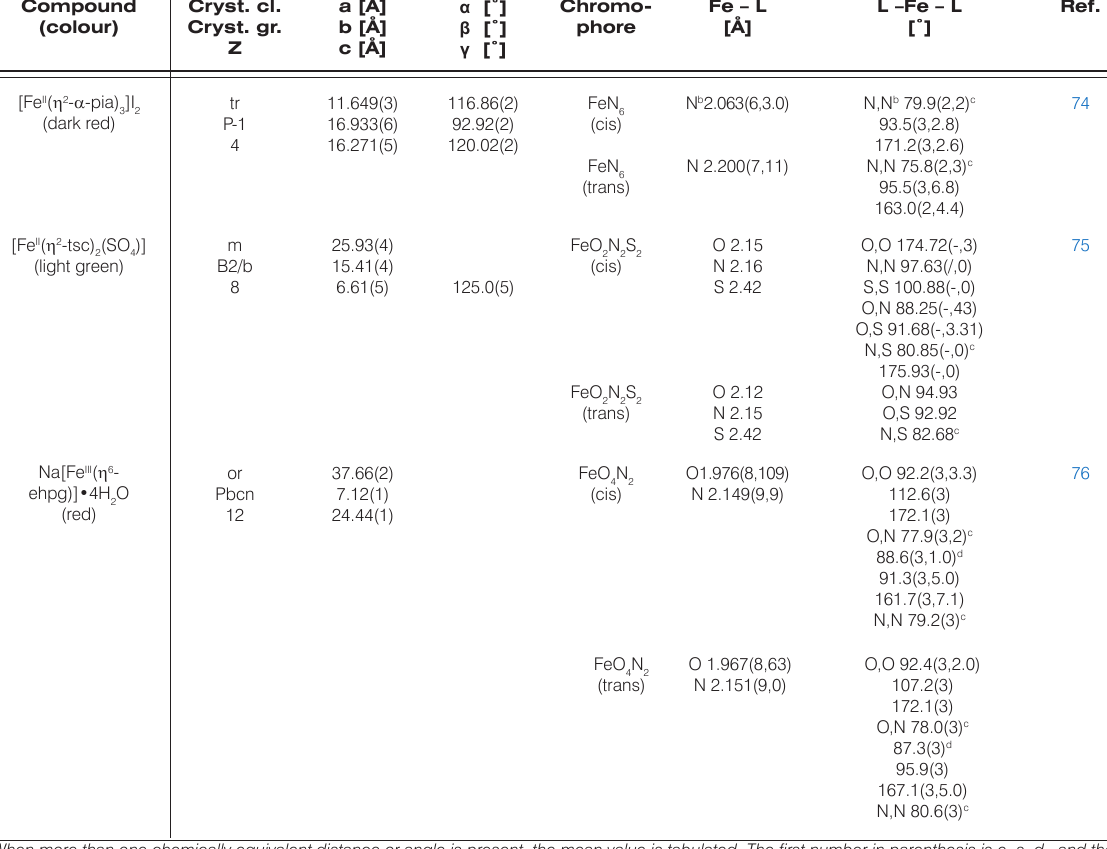
Table 6. Crystallographic and structural data for monomeric iron coordination compounds – cis – trans – isomers a